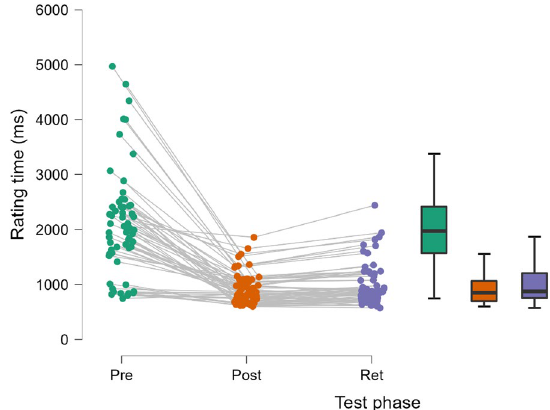
Fig. 9 Individual median rating times are shown at pre‑training (pre, green), post‑training (post, orange), and retention (ret, purple) testing phases, as connected dot‑clouds per participant‑image type combination and boxplots to show both individual patterns and the population